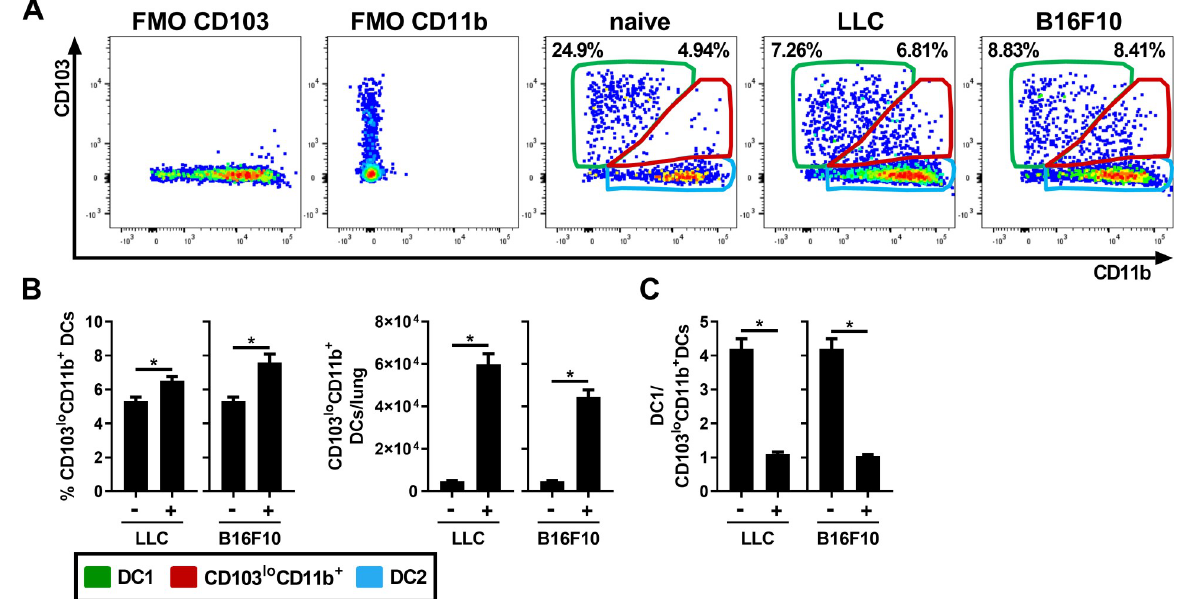
Fig 3. Accumulation of CD103 lo CD11b + DCs following lung cancer development. Lung DC populations were analyzed by flow cytometry following an i.v. injection of LLC and B16F10 cancer cells. (A) Representative flow cytometry profiles of CD103 and CD11b expression on MHC II hi CD11c + DCs, showing conventional DC1 population in green, DC2 population in blue and CD103 lo CD11b + DCs in red. (B) Percentage and number of CD103 lo CD11b + DC. (C) Ratio of CD103 + CD11b -/lo DC1 (green) on CD103 lo CD11b + (red) DCs. Data are expressed as mean ± SEM. n = 5–8 mice per group and are representative of two independent experiments. � = p < 0.05 using an unpaired t-test with Welch’s correction.